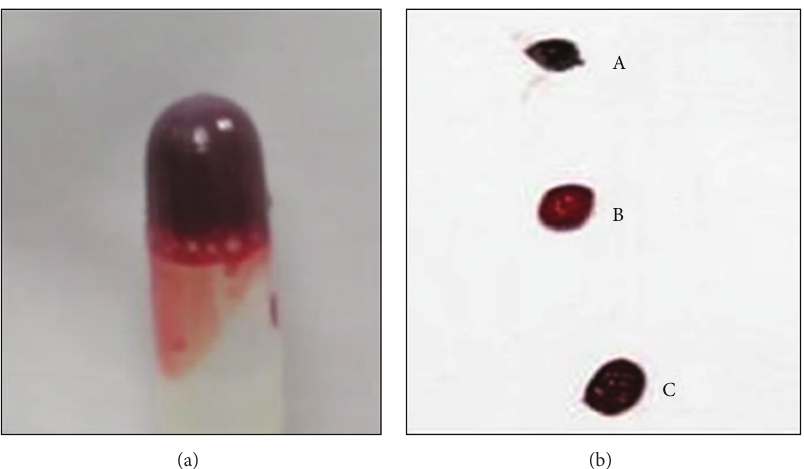
Figure 1: (a) The photo of the clot using HCGT in the test tube; (b) the photo of clots: (A) normal, (B) LTP, and (C) HIGM.